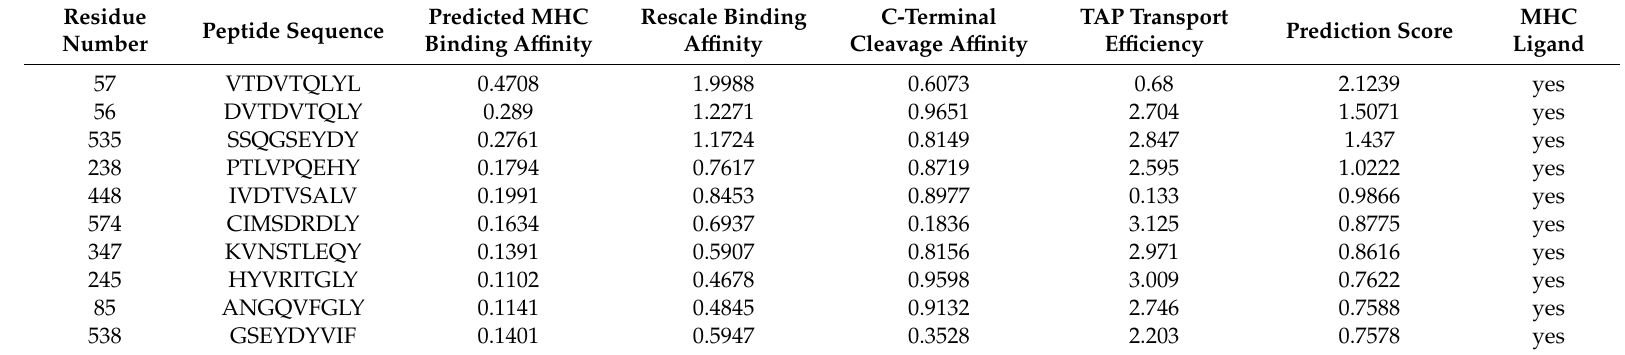
Table 8. Predicted CTL from SARS-CoV-2 Nsp13 helicase